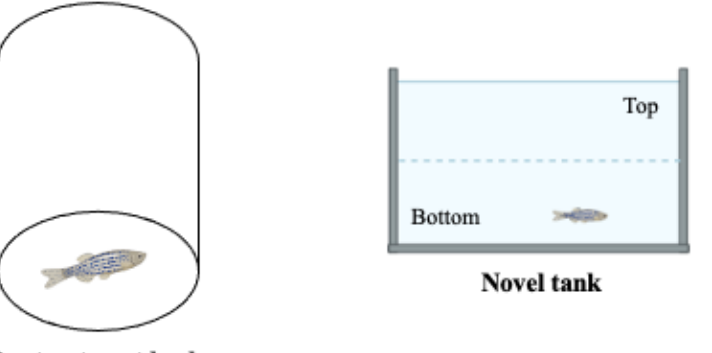
Figure 12. The novel tank diving test. Zebrafish are first exposed to a pretreatment beaker before being moved into the novel tank for behavioural observation and phenotyping. Created with Bio- render.com.